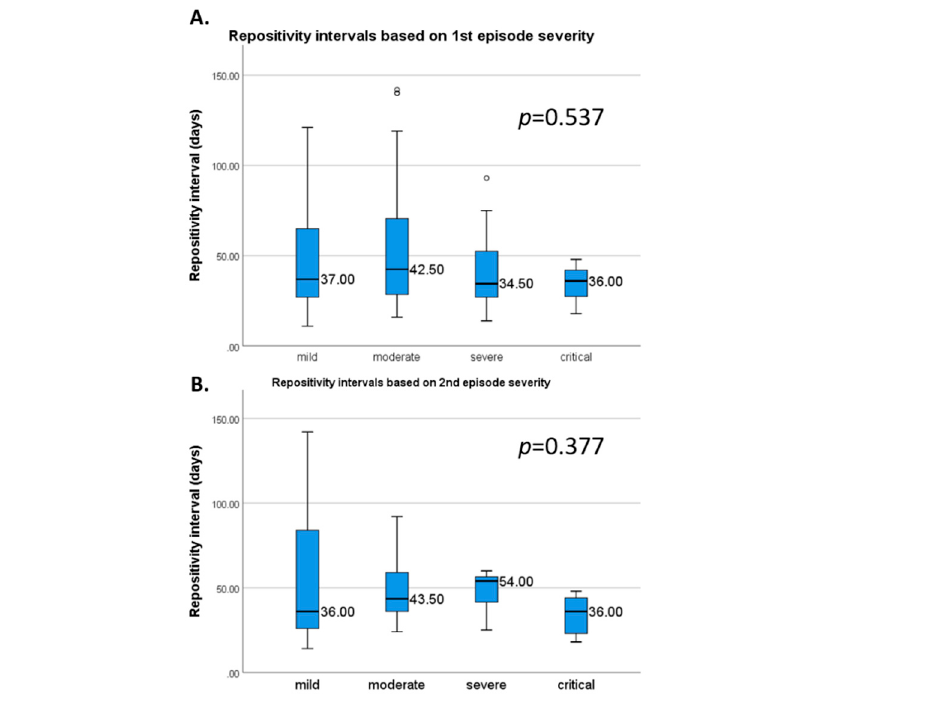
Figure 3. Median repeated positivity lengths based on the first ( A ) and second episode severity ( B ). Error bars represent 1.5 times the interquartile range. Table 2. Mean repeated positivity length based on the listed parameters.